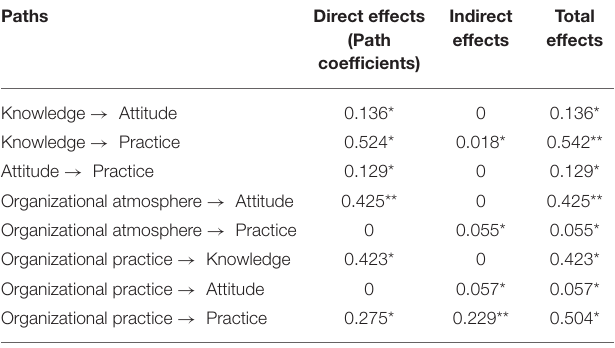
TABLE 4 | The results of standardized direct, indirect, and total